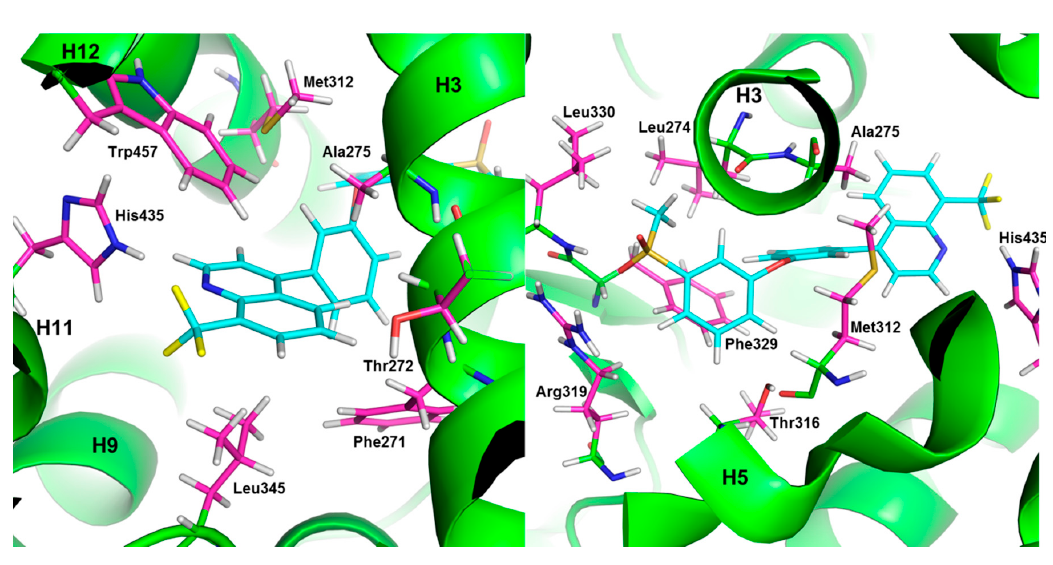
Figure 10. The binding pocket of LXR β based on the optimized 3KFC crystal structure.